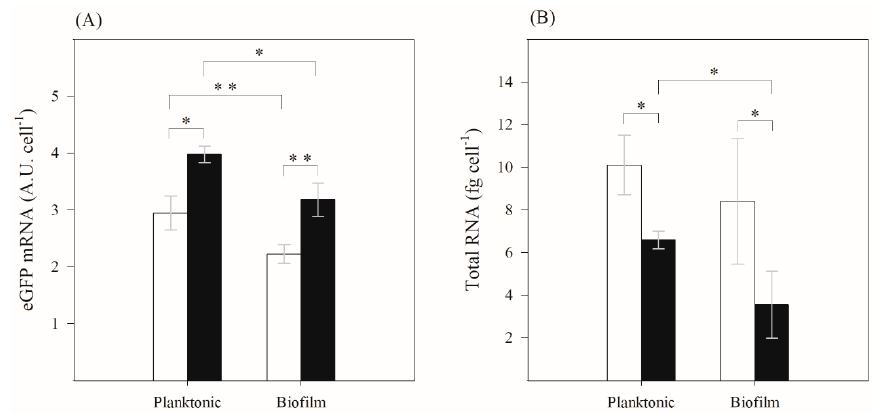
Figure 3. ( A ) Quantification of eGFP gene transcription and ( B ) total RNA concentration for planktonic and biofilm cells on day 7. Induced ( (cid:4) ) and non-induced ( (cid:3) ) cells. The averages ± SDs (indicated as bars) for two independent experiments for each condition (considering the same quantity of cells) are illustrated. Statistical analysis corresponding to each time point is represented by * for a confidence level greater than 90% ( p < 0.1) and by * * for a confidence level greater than 95% ( p < 0.05).